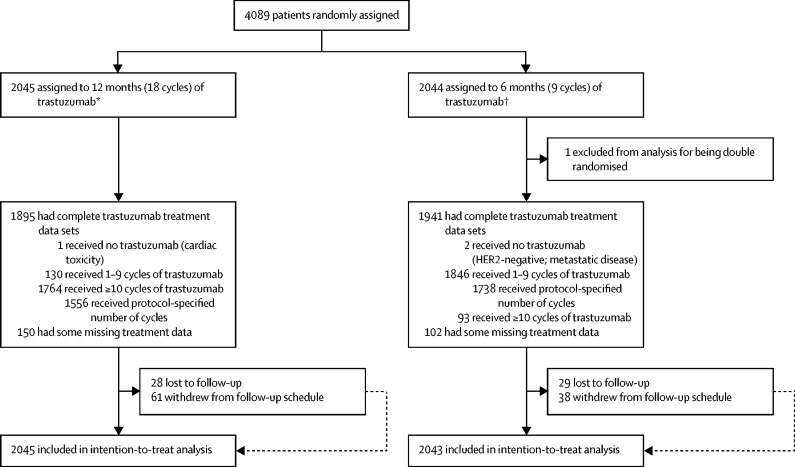
Trial profile*Seven patients were found to be ineligible after randomisation (four had previous cancer or ductal carcinoma in situ treated with surgery and radiotherapy, two were HER2 negative, and one had primary cancer confined to the axilla). †11 patients were found to be ineligible after randomisation (seven had previous cancer or ductal carcinoma in situ treated with surgery and radiotherapy, one was HER2 negative, two had metastatic disease, and one had received >9 cycles of trastuzumab).